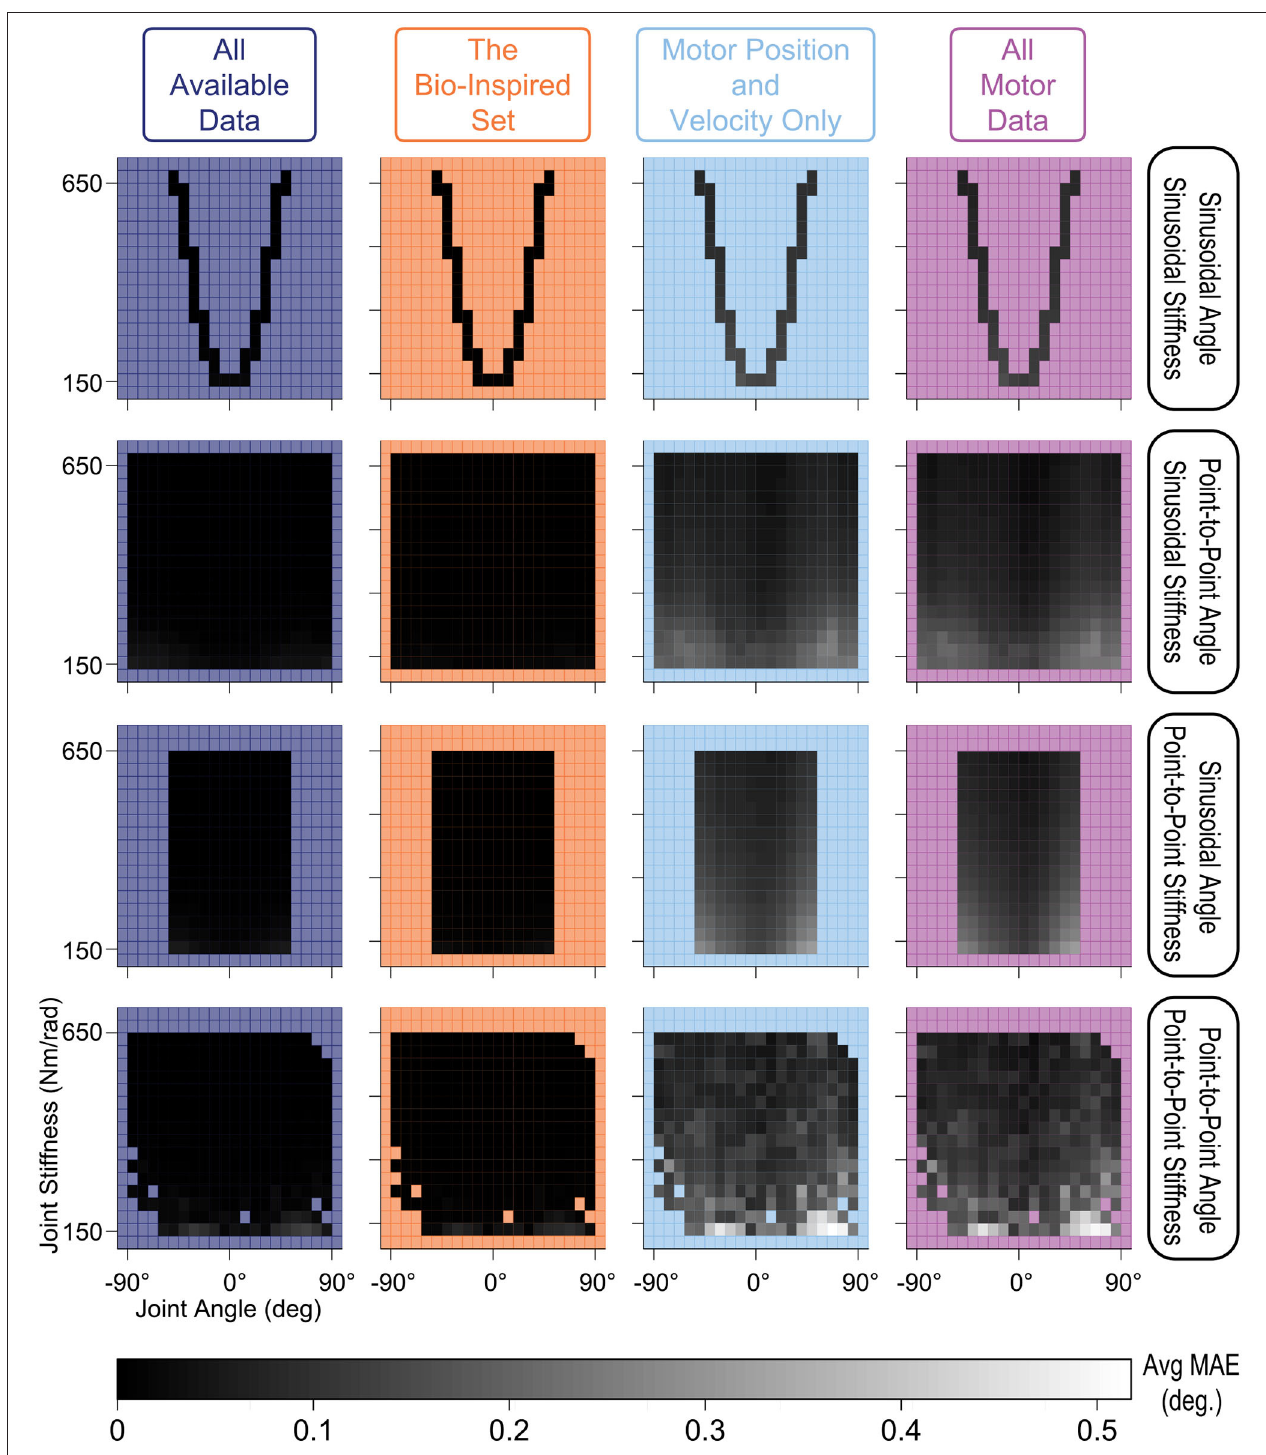
FIGURE 15 | Linear-scale heatmap of the average MAE vs. joint angle and joint stiffness for sinusoidal and point-to-point trajectories ( Very High tendon stiffness experiment). Similar to the default Low tendon stiffness results plotted in Figure 10 , the ANNs trained with tendon tension data ( left two columns ) still ( i ) perform better and ( ii ) better generalize at lower stiffness values than ANNs trained only with motor data (although the difference is not as large).